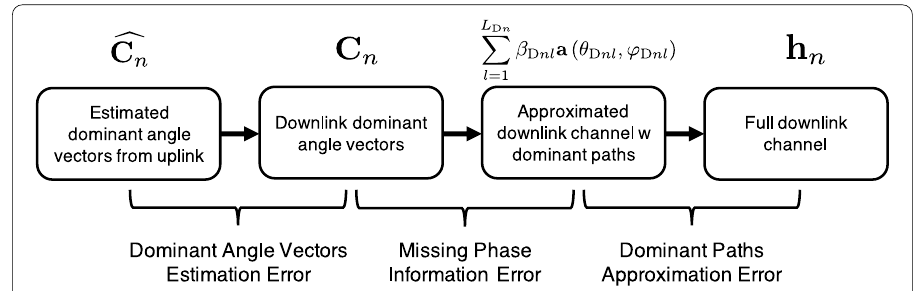
Fig. 1 The gap between estimated downlink dominant angle vectors and downlink full